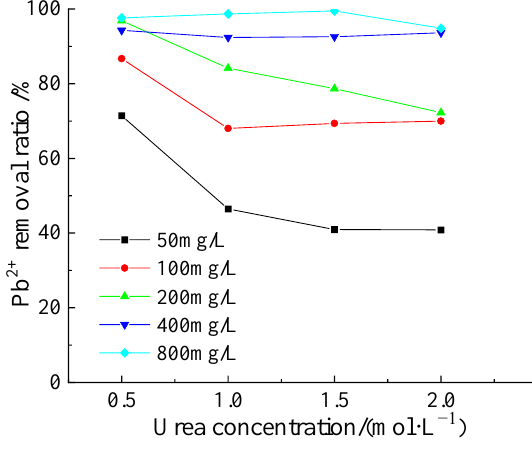
Figure 8. Removal ratio of Pb 2+ with different urea concentrations (( a ) C urea = 0.5 mol/L; ( b ) C urea = 1.0 mol/L; ( c ) C urea = 1.5 mol/L; ( d ) C urea = 2.0 mol/L).